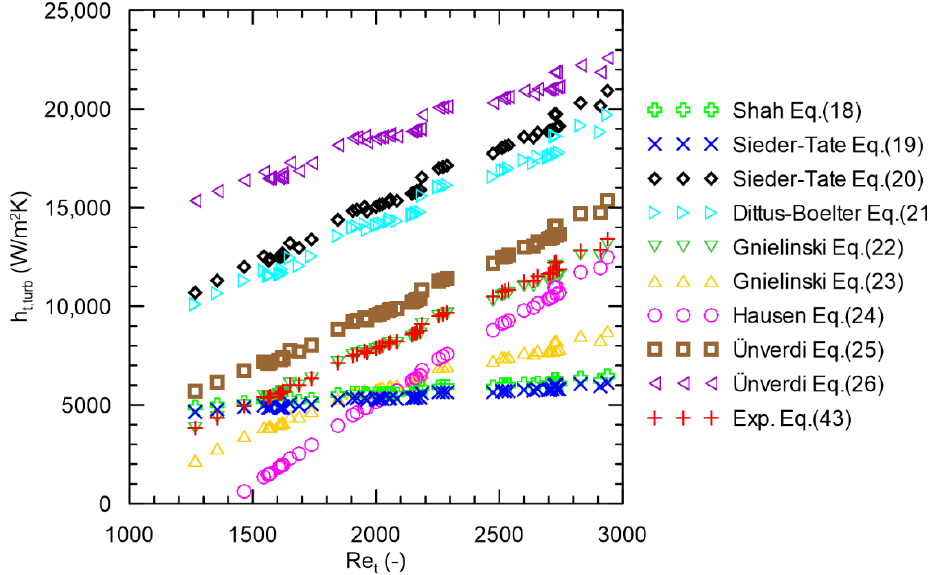
Figure 5. Heat transfer coefficient for the transition or turbulent flow inside tubes h t , turb as a function of the tube side Reynolds number Re